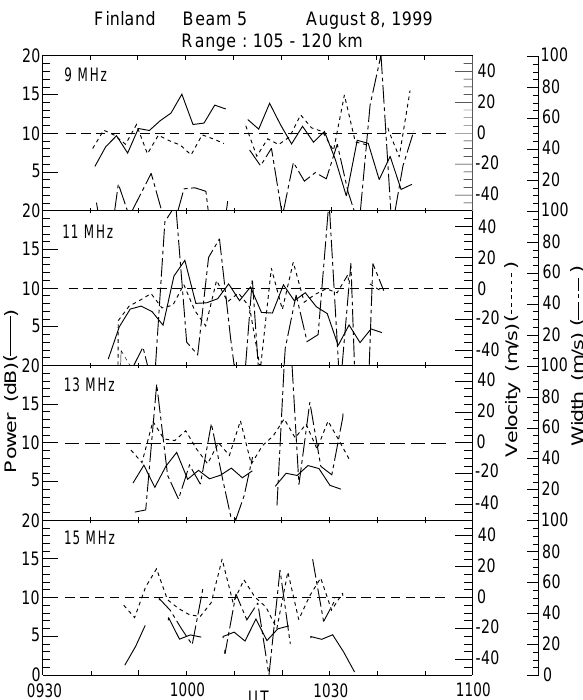
Fig. 7. Time variations of echo power (solid line), Doppler velocity (dashed line) and spectral width (dot-dashed line) at four frequen- cies at range gate of 105–120 km on beam